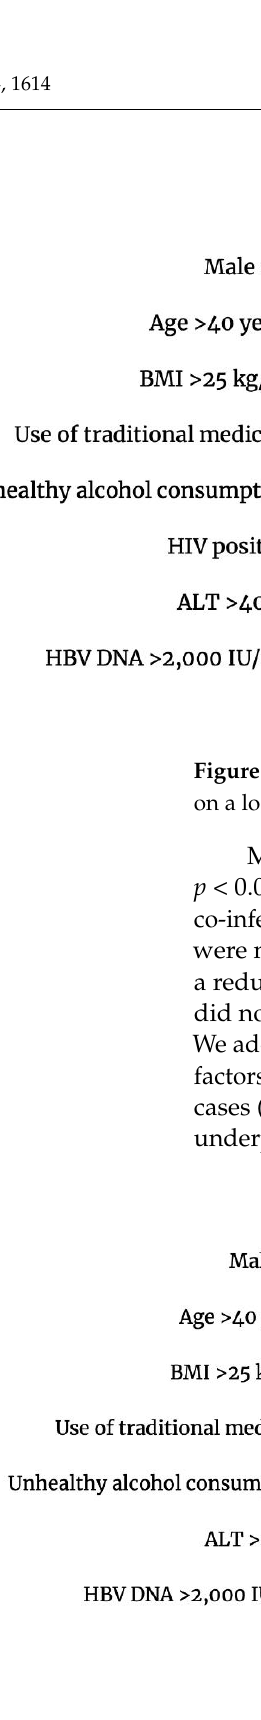
5 of 10 Figure 1. Proportion of participants in the different liver stiffness measurement categories, by HIV